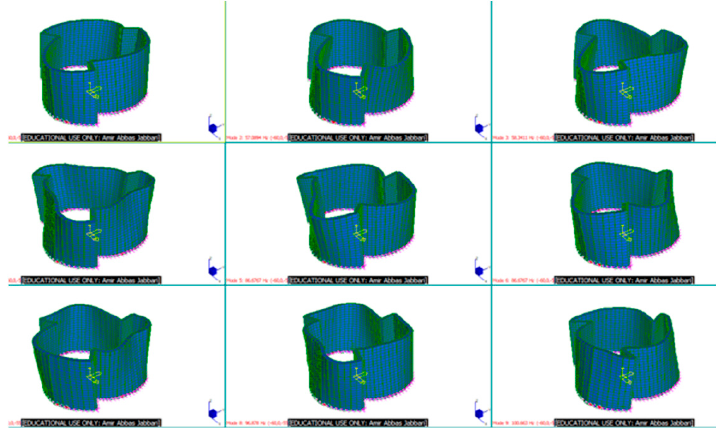
Figure 15. Deformed shape of the building associated with each mode.